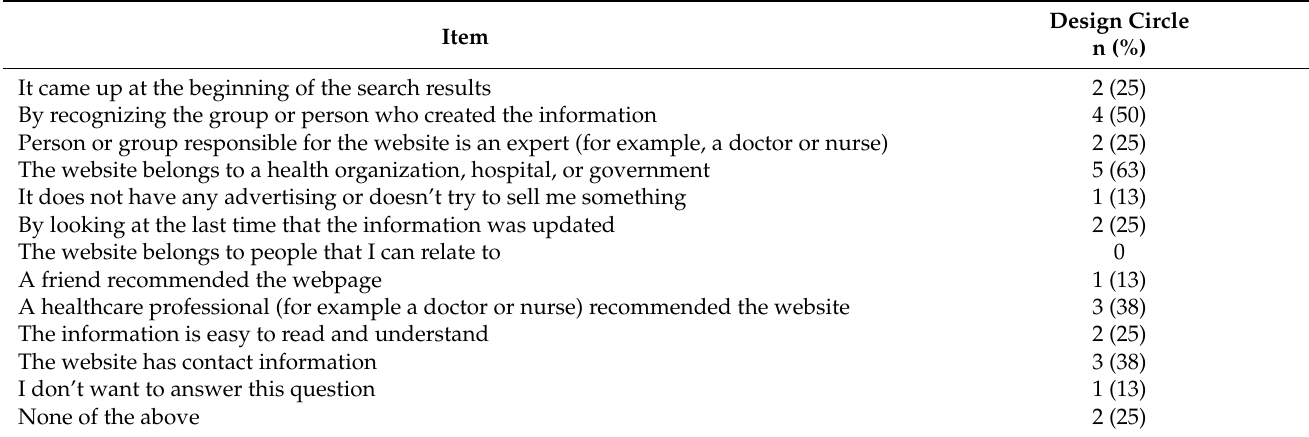
Table 3. Trustworthiness of Online Health